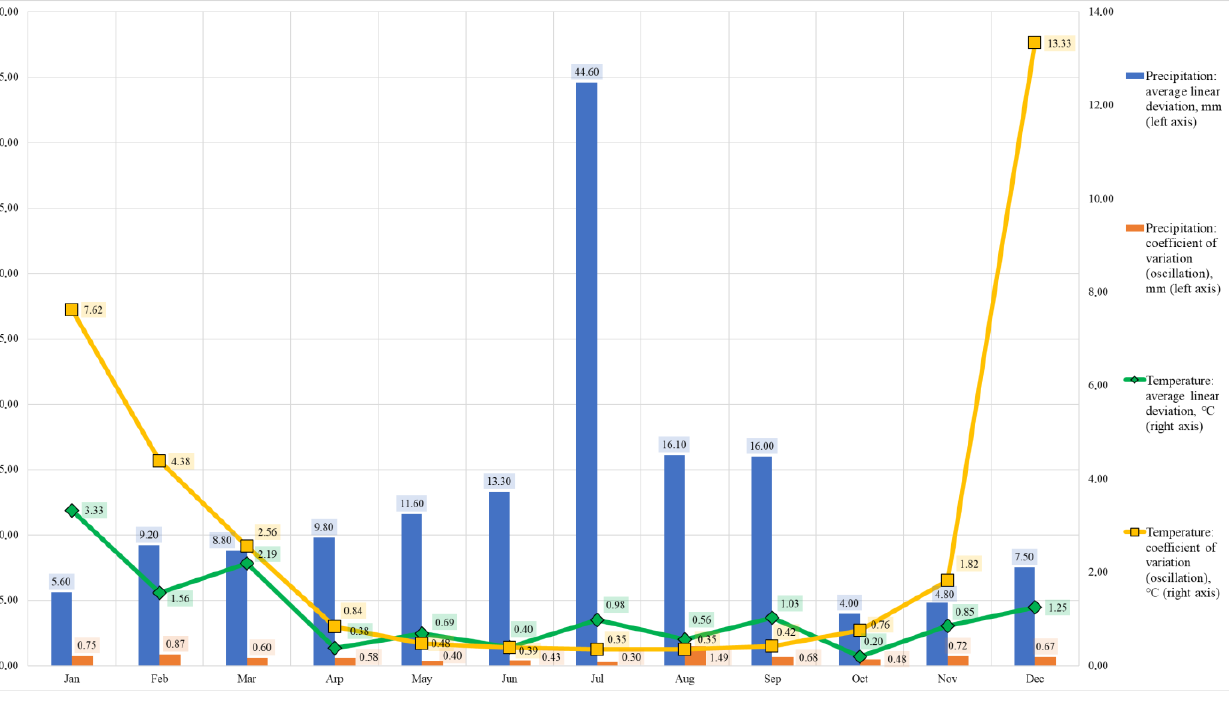
Figure 3. Meteorological parameters: average linear deviations and coefficients of variation. Source: authors’ development based on the Stavropol Center for Hydrometeorology and Environmental Monitoring